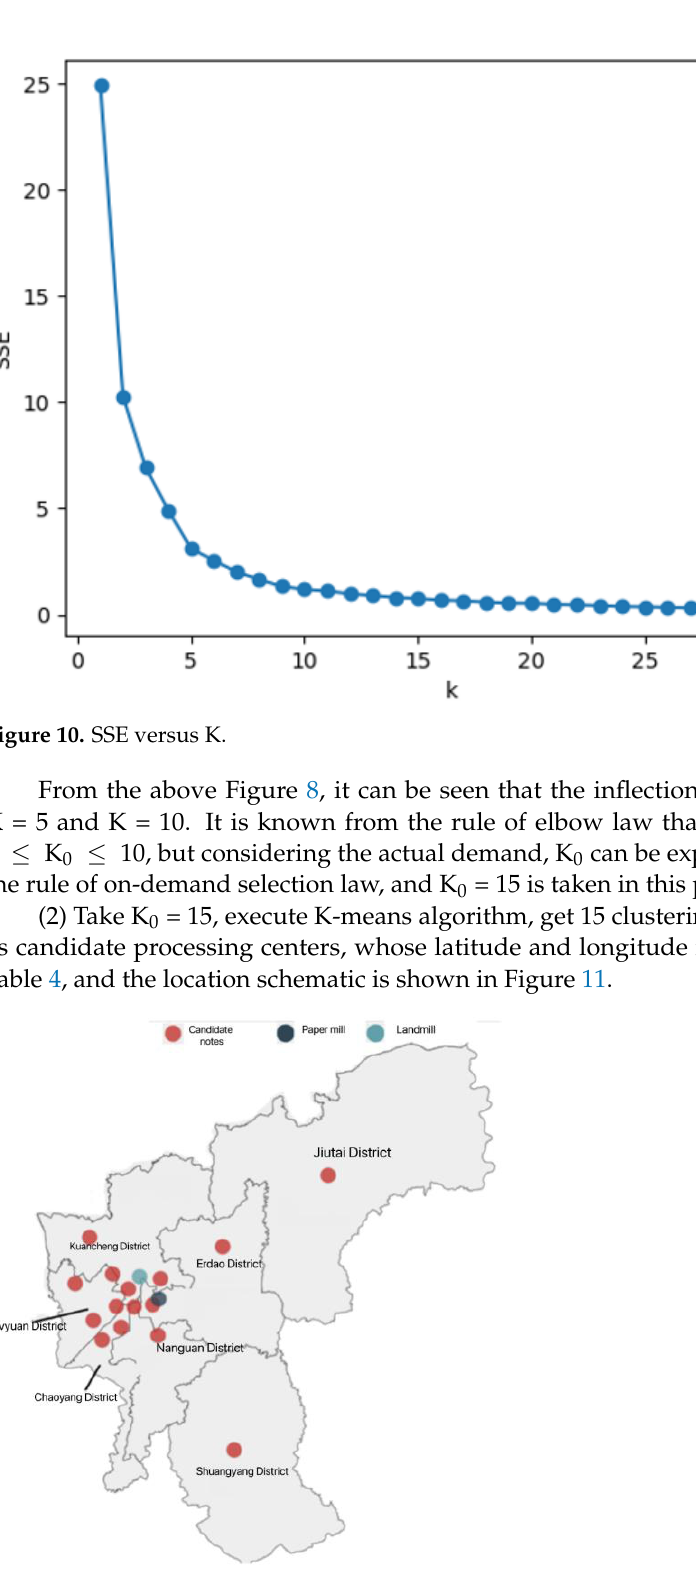
Figure 11. Schematic diagram of the location of the candidate nodes, paper mill, and landfill .